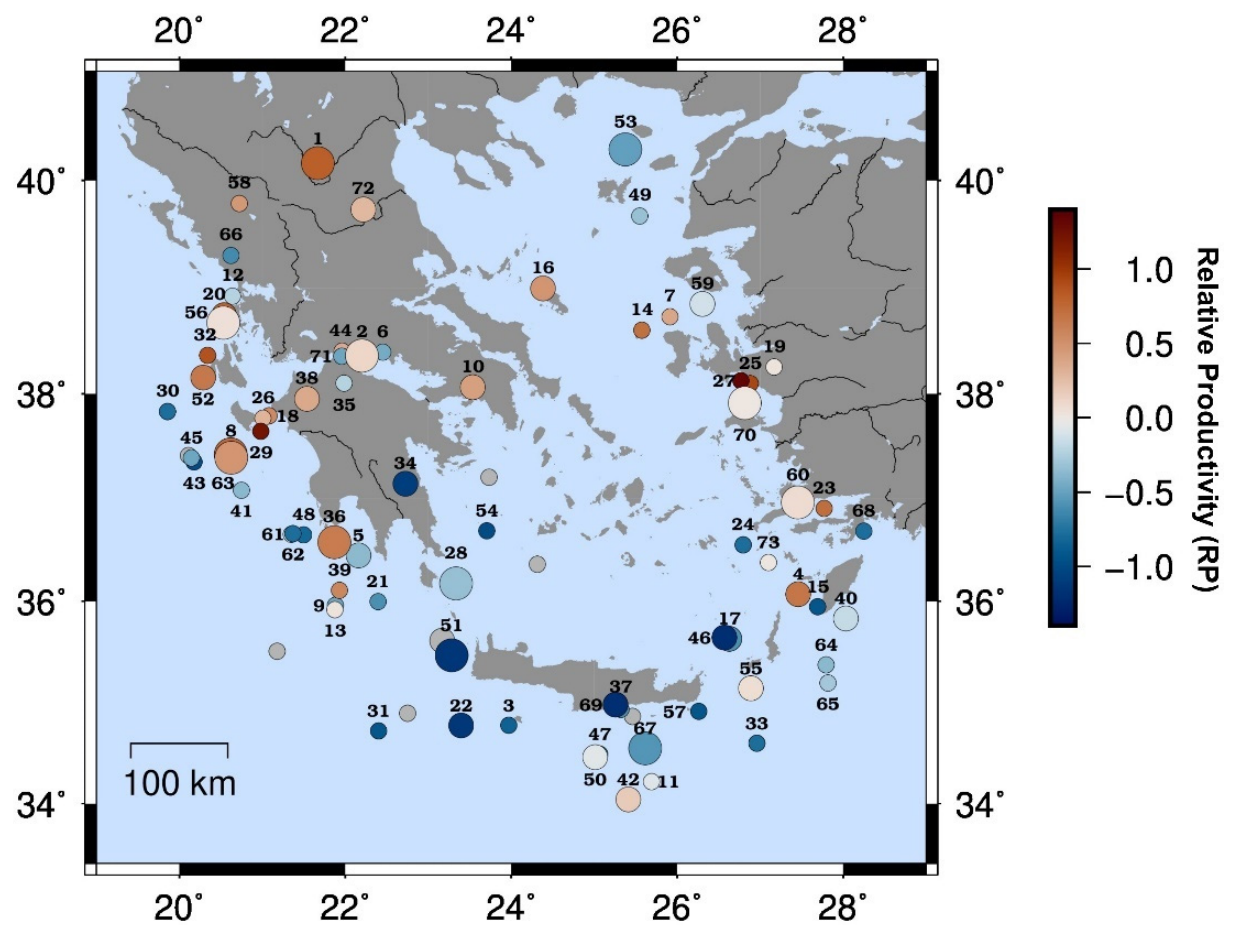
Figure 9. Map of mainshocks ( M w ≥ 5.5), color-coded according to the relative productivity value of their respective sequences. Gray circles indicate isolated mainshocks (without aftershocks). The serial numbers of each mainshock correspond to those of Table